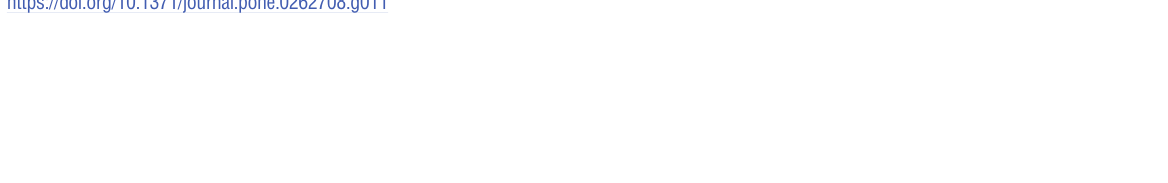
PLOS ONE | https://doi.org/10.1371/journal.pone.0262708 January 28,